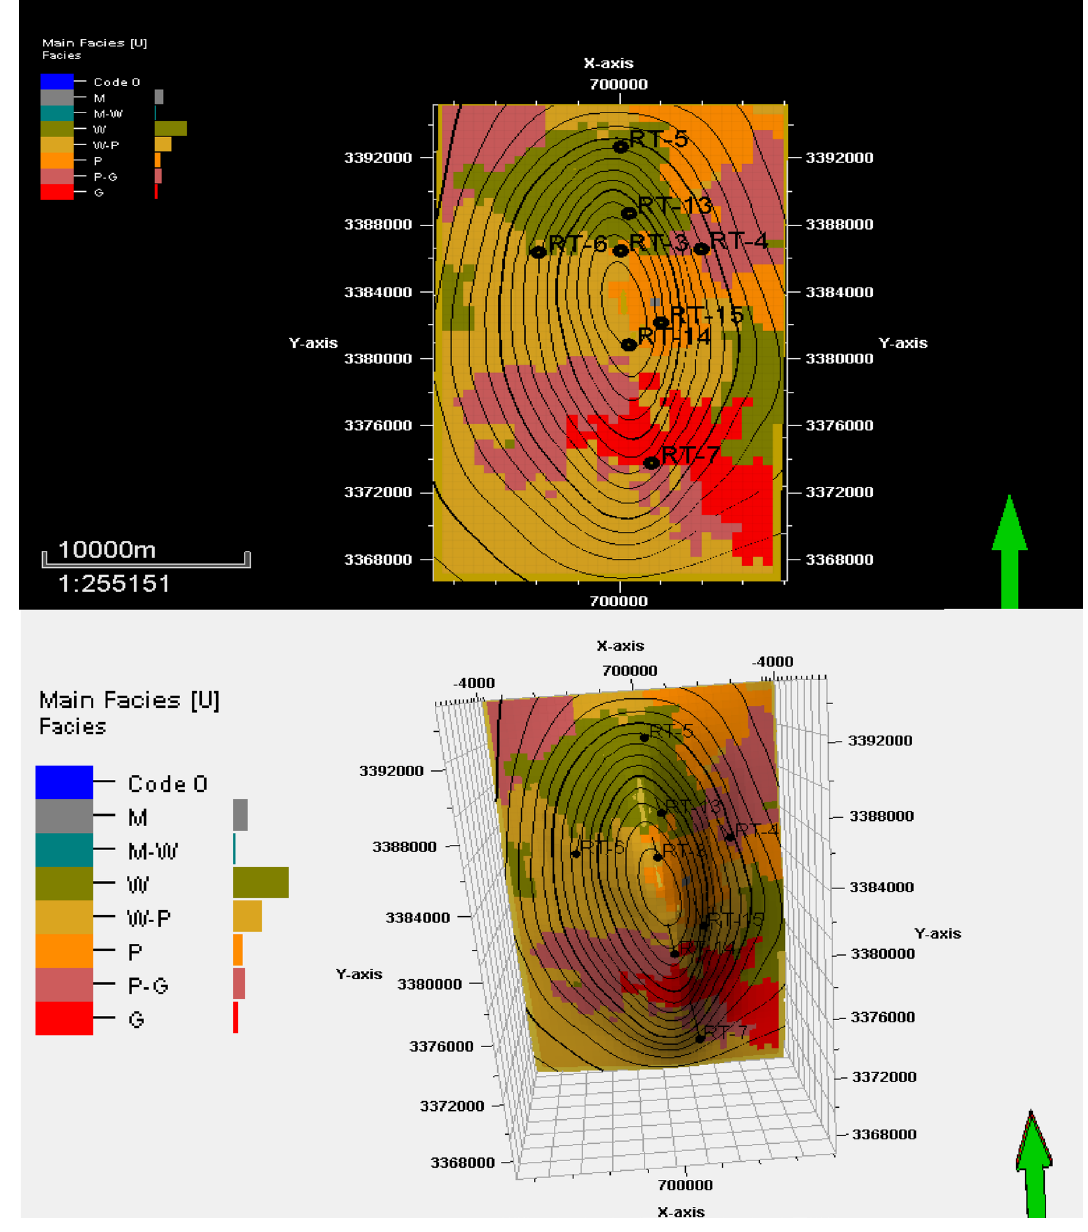
Figure 11. Facies distribution of the top surface of reservoir unit